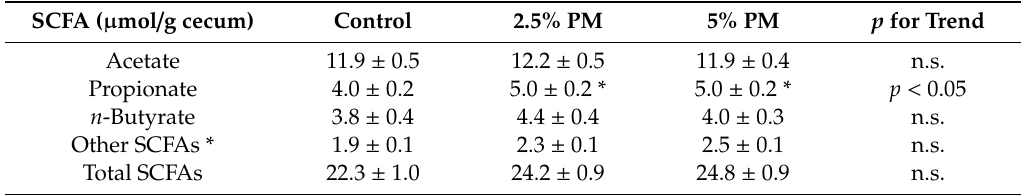
Table 6. Concentration of short-chain fatty acids (SCFA) in the cecal digesta.